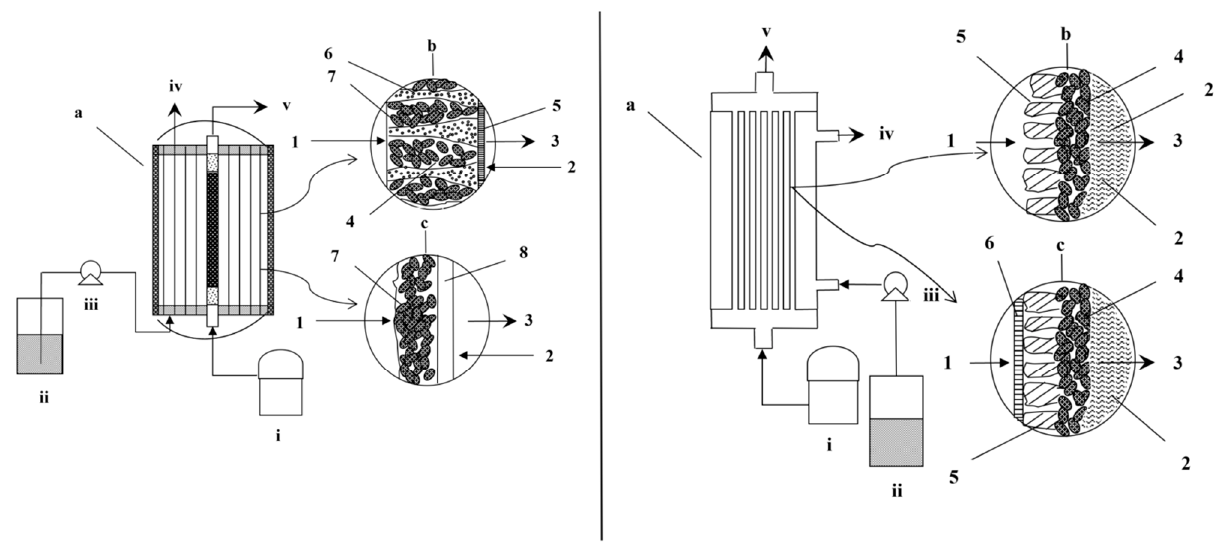
Figure 2. ( Left ) Membrane bioreactor (MBR) with gas fed through the outer surface of the membrane fibers and the liquid flowing through the hollow fiber lumens. ( Right ) Membrane bioreactor (MBR) with gas fed through the hollow fiber lumens while the liquid flows through the outer surface. The description of the figures can be found elsewhere [39]. Reprinted from [39] (Copyright 2011), with permission from the Society of Chemical Industry and John Wiley and Sons Ltd.